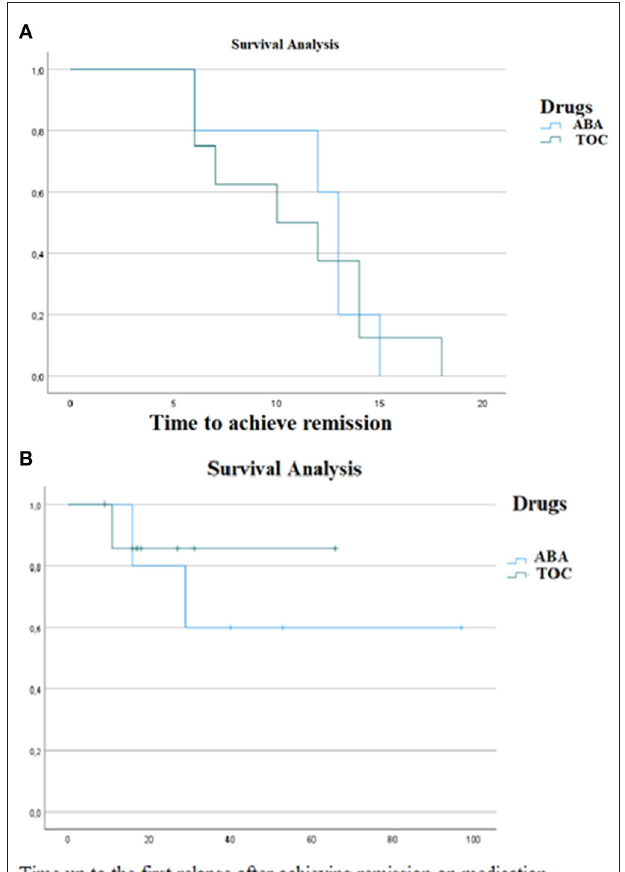
FIGURE 1 | A survival analysis was conducted to evaluate difference (A) in the time to achieve remission and (B) in the time to first relapse after remission was achieved, between the group of patients treated with Tocilizumab and the group of patients treated with Abatacept. No significative difference were evaluated in the two outcomes [ (A) χ ² 0, p 0.999; (B) χ ² 0.29, p 0.5]. ABA, Abatacept; TCZ,